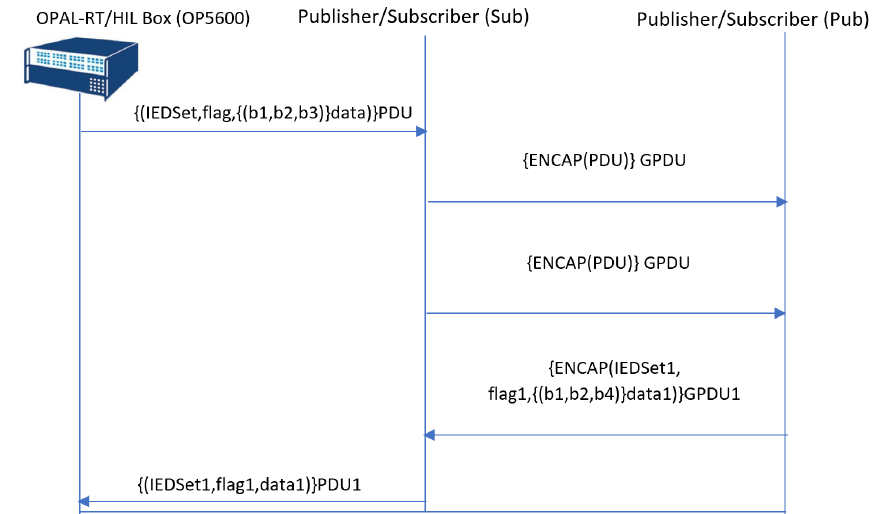
Figure 6. SPDL flow of the GOOSE protocol without IEC